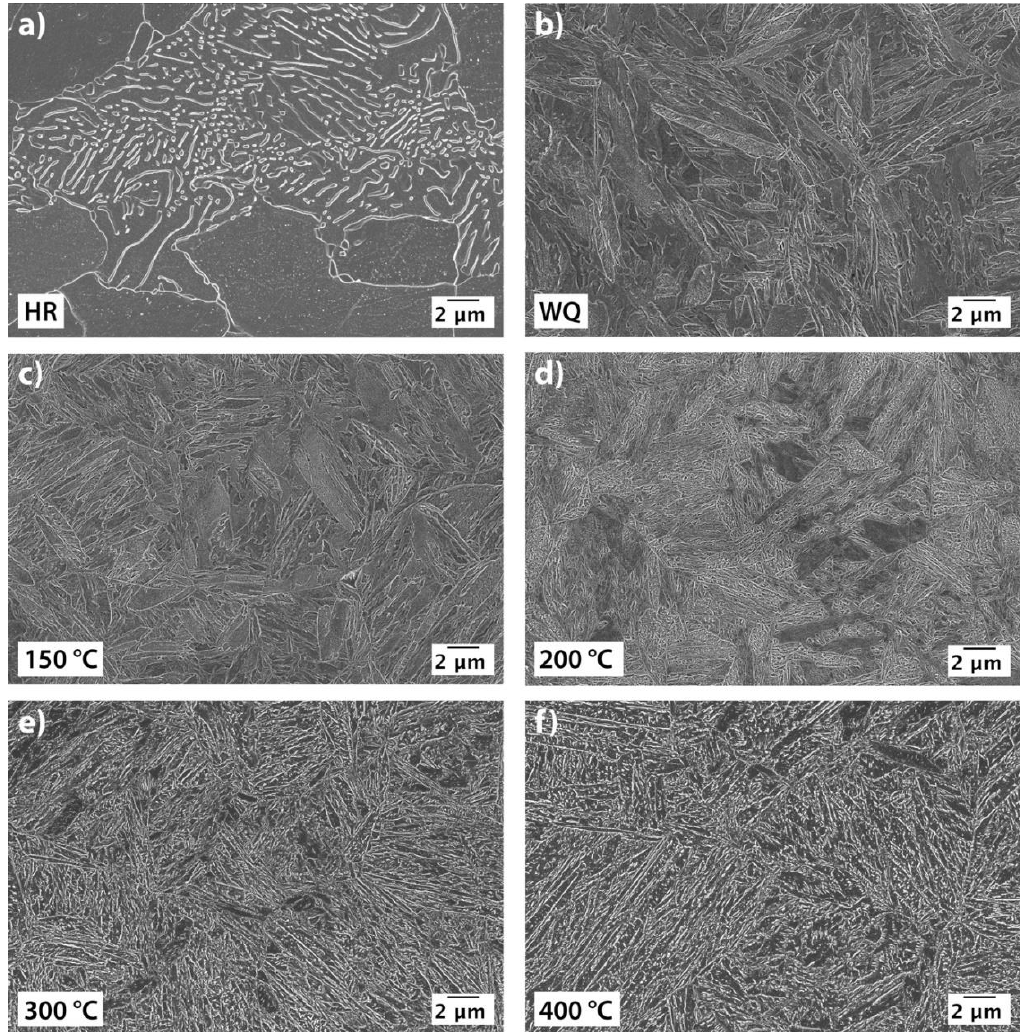
Figure 3. Field emission scanning electron microscope (FESEM) micrographs of the tested steels. Images taken from ¼ depth from the top surface in normal-to-rolling direction (longitudinal). Samples: ( a ) hot-rolled , ( b ) water quenched, ( c ) tempered at 150 °C, ( d ) tempered at 200 °C, ( e ) tempered at 300 °C, ( f ) tempered at 400 °C.